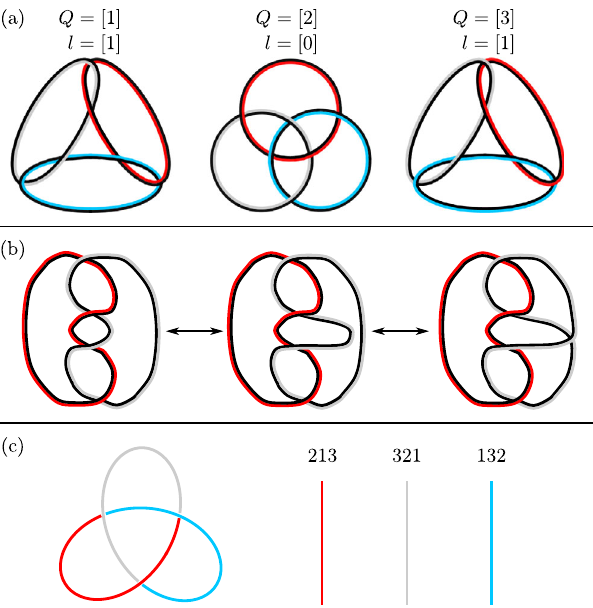
Fig. 4 Examples of topologically protected and unprotected colored knots and links. a Three non-trivial Q 8 -colored links and the values of the linking invariant l and the Q -invariant for each of them. Interestingly, the topological protection the defect at the center, which is a Q 8 -colored version of the Borromean rings, cannot be detected using the linking invariant l . It is established in the supplementary material that, up to topologically allowed reconnections and strand crossings, each Q 8 -colored link with a nontrivial Q -invariant is equivalent to either one of the defects depicted above, or the disjoint union of one of the above defects, and a purple loop. b Q 8 -colored link that is not topologically protected. Even though no nontrivial modi fi cations can be applied on the crossings, the link may be unlinked by deforming one of the arcs, and then performing a local reconnection. The end result, the rightmost link diagram, is an unlink. Accordingly, the link has trivial invariants l and Q . Note that a red loop and a blue loop could not be form the Hopf link because such a con fi guration does not admit a valid bicoloring. c Topologically protected knot colored by the elements of the permutation group S 3 . Each color corresponds to one of the three transpositions, as indicated. Transpositions are their own inverses, and therefore the direction does not